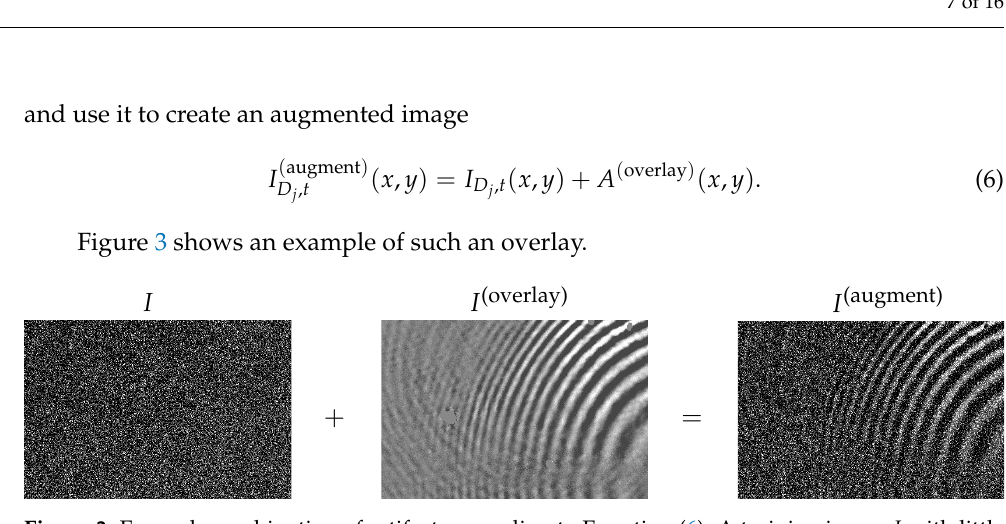
Figure 3. Example combination of artifacts according to Equation (6). A training image I with little correlated artifacts is augmented with wave artifacts A ( overlay ) to expand the present artifact patterns. The combination of artifacts is noted as I ( augment )